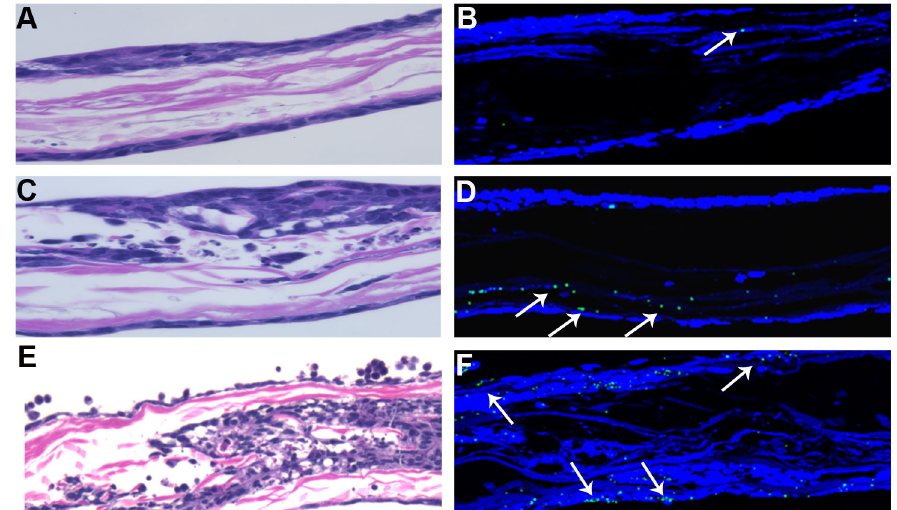
Figure 3. Labeled ricin transits across HCT-8 cell organoids over time. Organoids intoxicated with Alexa Fluor ® 700-labeled ricin for 1 (A, B), 6 (C, D), and 24 (E, F) hours were removed from the vessels and processed. H&E staining was used to visualize the structure of the organoids (A, C, E; pink represents scaffold and purple represents HCT-8 cells). Confocal fluorescence microscopy was used to identify the labeled toxin (B, D, F); green indicates the presence of ricin and blue indicates DAPI-stained nuclei. White arrows show labeled ricin in the sections. For each time shown, tissues subjected to H&E or confocal microscopy are from the same organoid but are not serial sections. Magnification: 100x (A, C, E) and 100x (B, D, F). doi: